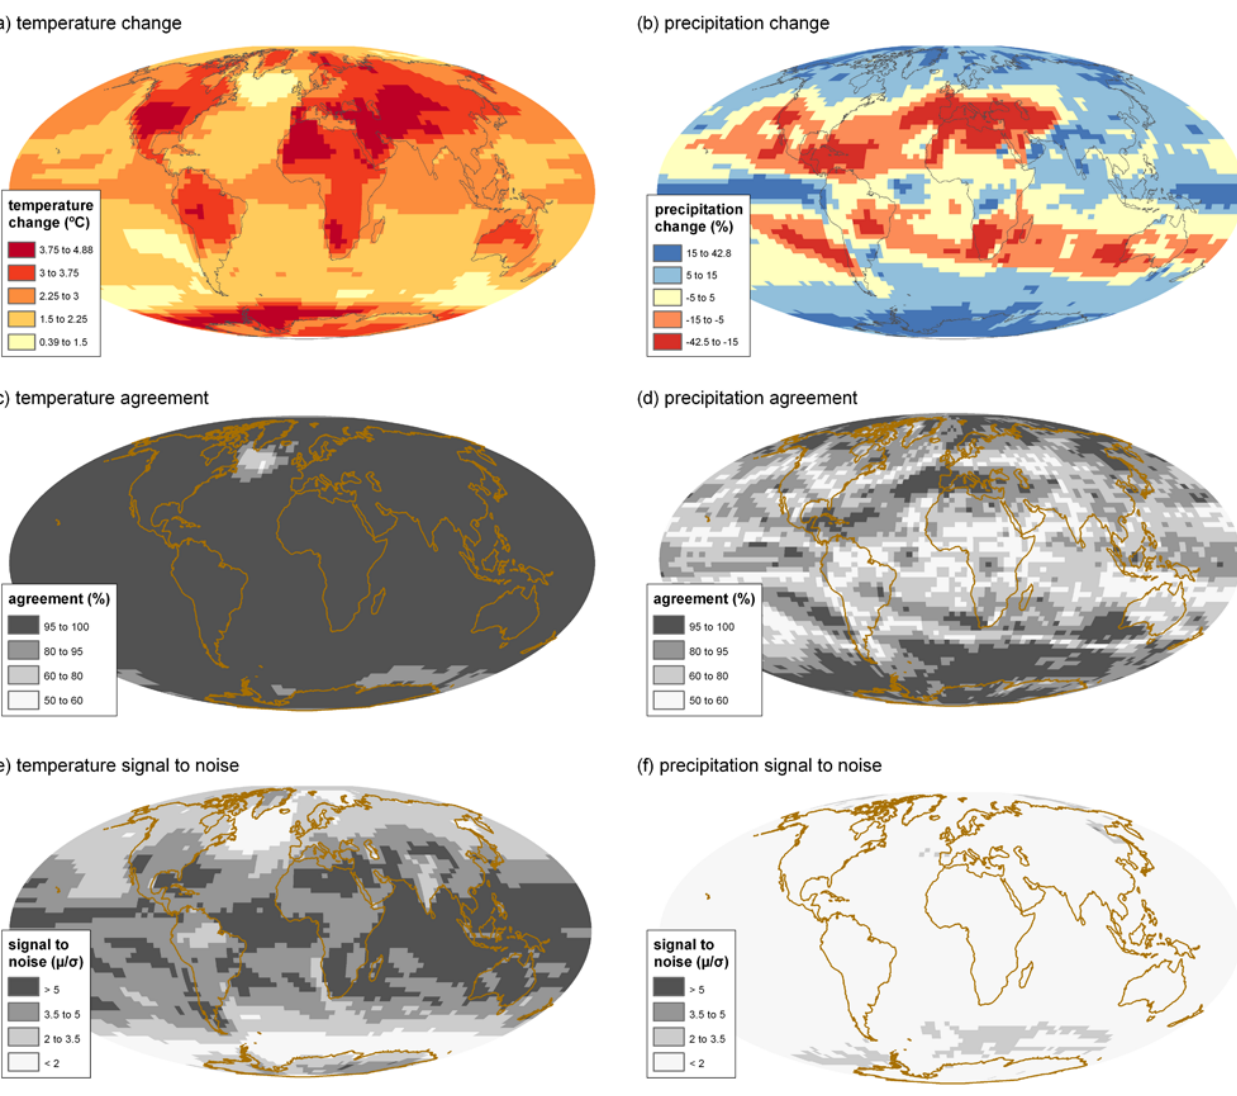
Fig. 6. Change in temperature (a) and precipitation (b) between 1961–1990 and 2070–2099 for the mean of the IPCC AR4 ensemble based on the SRES A1B scenario. Model agreement percentage across the ensemble for (c) temperature and (d) precipitation. Signal-to-noise ( µ / σ) across the ensemble for (e) temperature and (f)